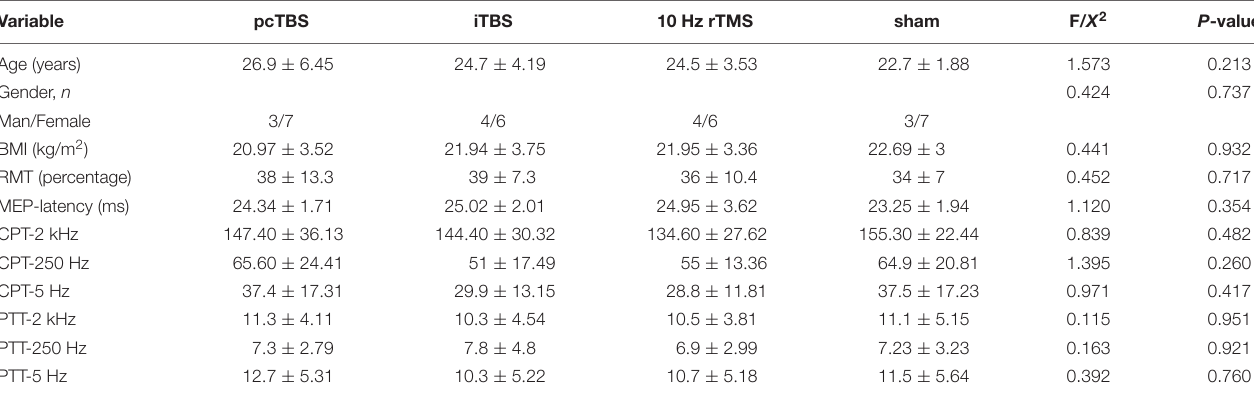
TABLE 1 | Baseline information for four groups.